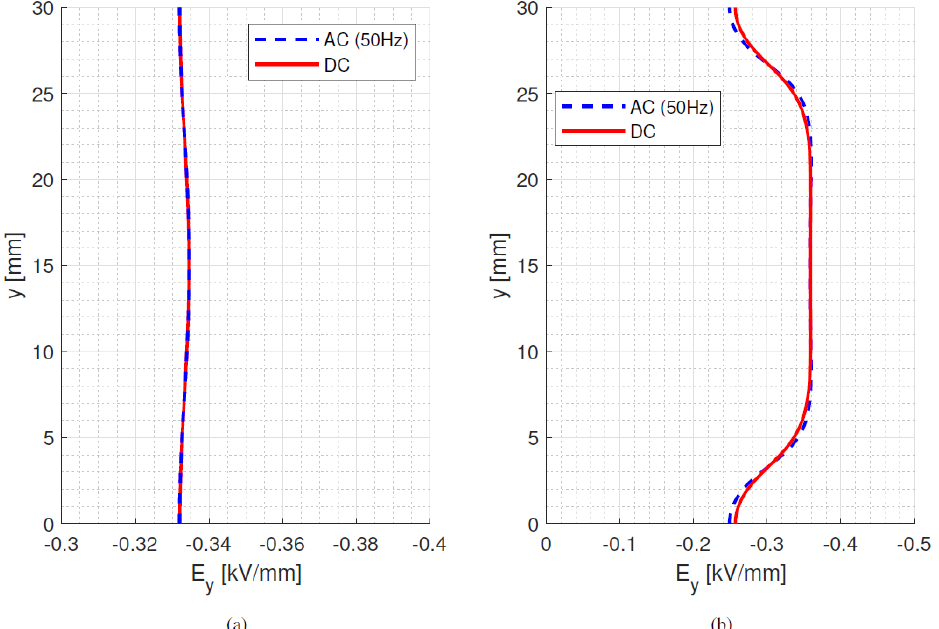
Figure 2. Bulk ( a ) and surface ( b ) ac and dc steady-state field for 10 kV at 65 °C. Model parameter values from Table 1.